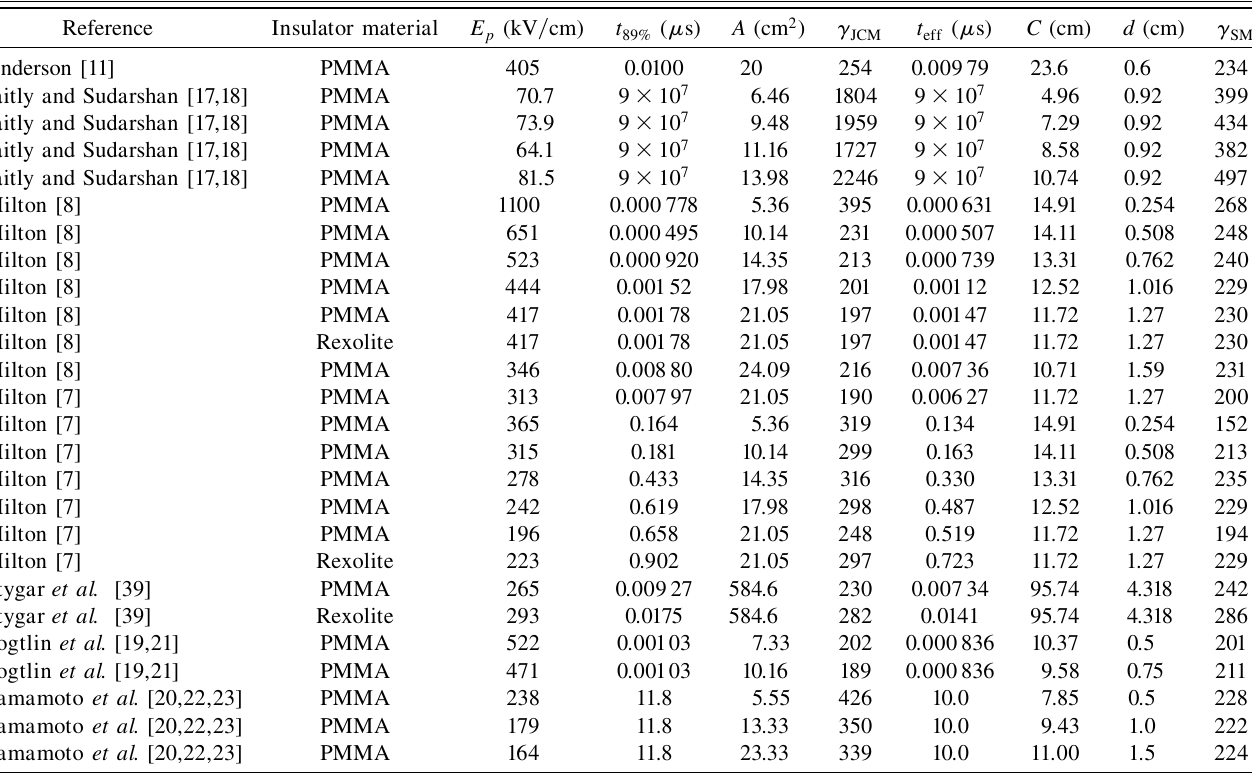
TABLE I. Summary of insulator-flashover measurements. Each of these was obtained with an uncoated 45 (cid:1) polymethyl- methacrylate (PMMA) or cross-linked polystyrene (Rexolite) insulator between flat uncoated electrodes, at a pressure (cid:12) 10 (cid:2) 4 torr . The measurements were made with no external sources of charged particles or ultraviolet radiation, and a magnetic field due only to the displacement current that charged the capacitance defined by the insulator and electrodes. The sixth and tenth and (cid:24) , respectively. The constants assume E columns list for each measurement the JCM and statistical-model constants, (cid:24) p JCM SM is expressed in kV = cm , t and t in (cid:11) s , A in cm 2 , and C , d in cm. The quantity A is the total area of the vacuum-insulator 89% eff interface, the circumference C is that at the midplane of the vacuum-insulator interface, and the thickness d is as defined by Fig.